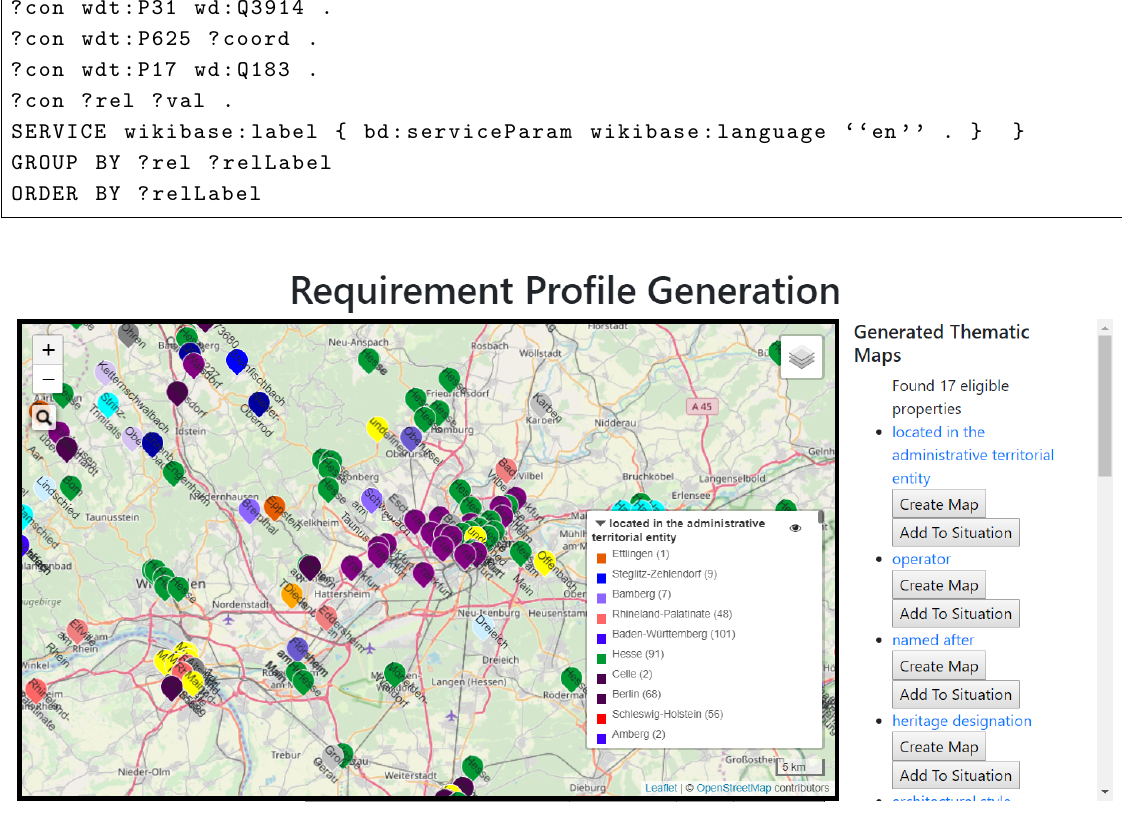
Figure 3. Requirement Profile Generation Tool: Highlights the result of the query in Listing 1 on the right and shows an example of “located in the administrative territorial entity” (P131) on the map. The attribute occurs frequently, has more than one unique attribute, but is not entirely unique, i.e., fulfils the given criteria for a thematic map